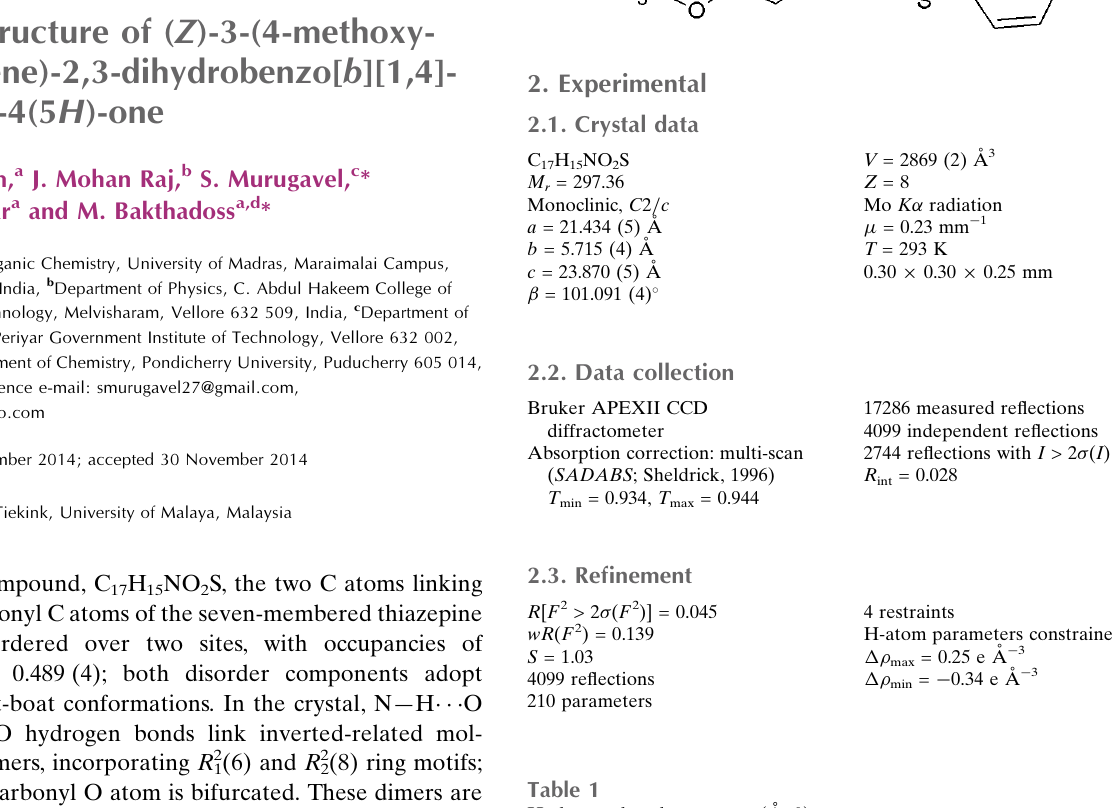
Hydrogen-bond geometry (A˚ , (cid:3)